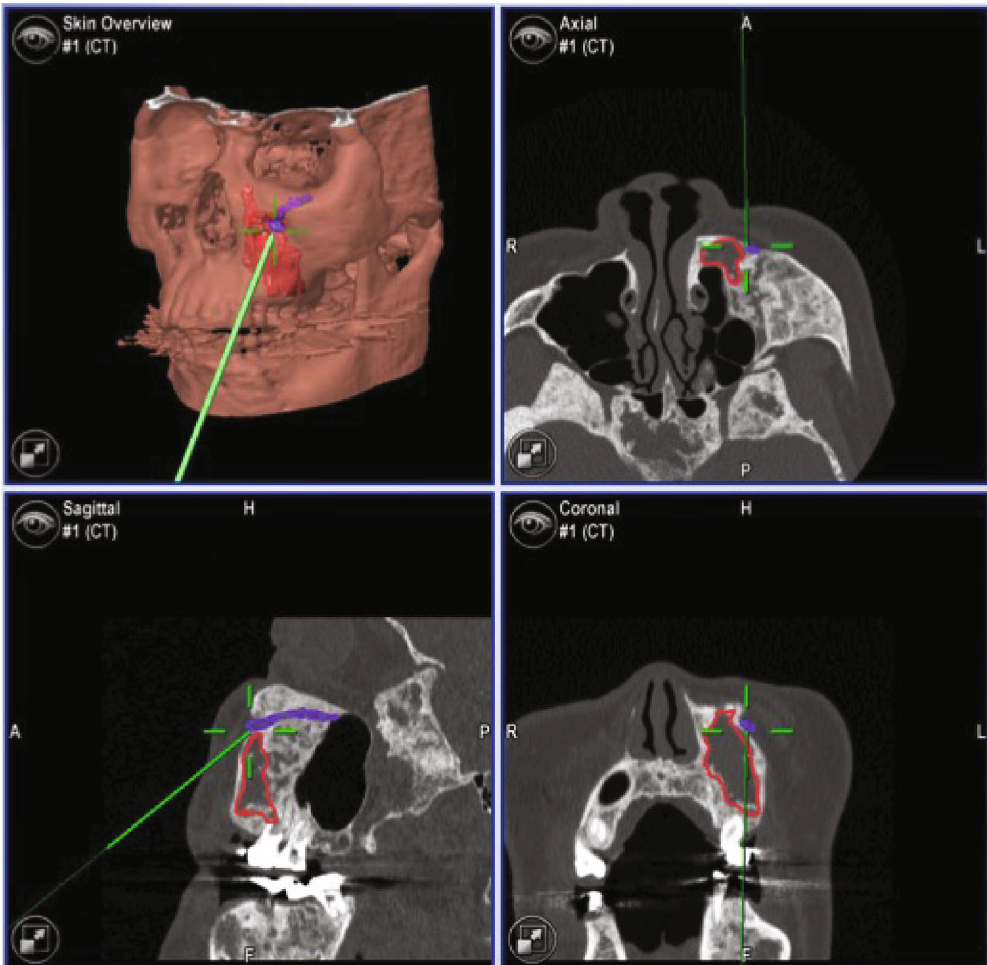
Figure 9: Intraoperative screenshot of the navigation system. The red line indicates the planned site for curettage. The contact of the pointer with the inferior border of the infraorbital foramen (purple line) is